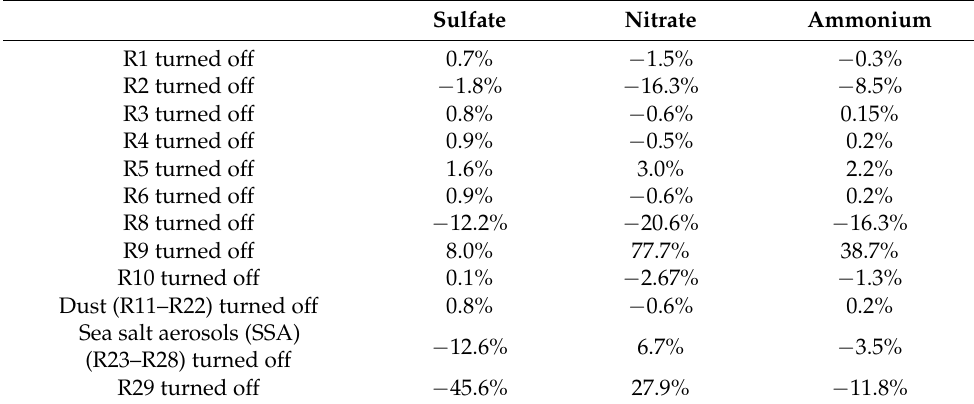
Table 1. Effect of the heterogeneous reactions on the SIA simulations. Sulfate Nitrate